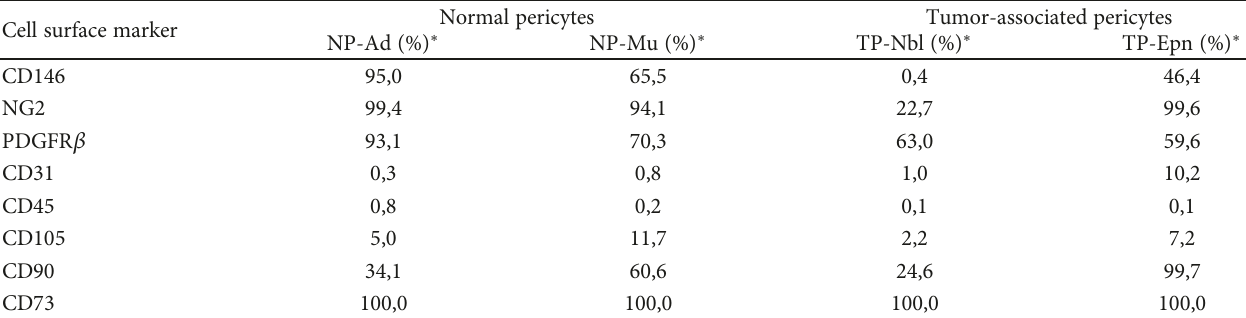
Table 1: Expression of cell surface markers in pericytes derived from normal tissue and pediatric nervous system tumors. Cell surface